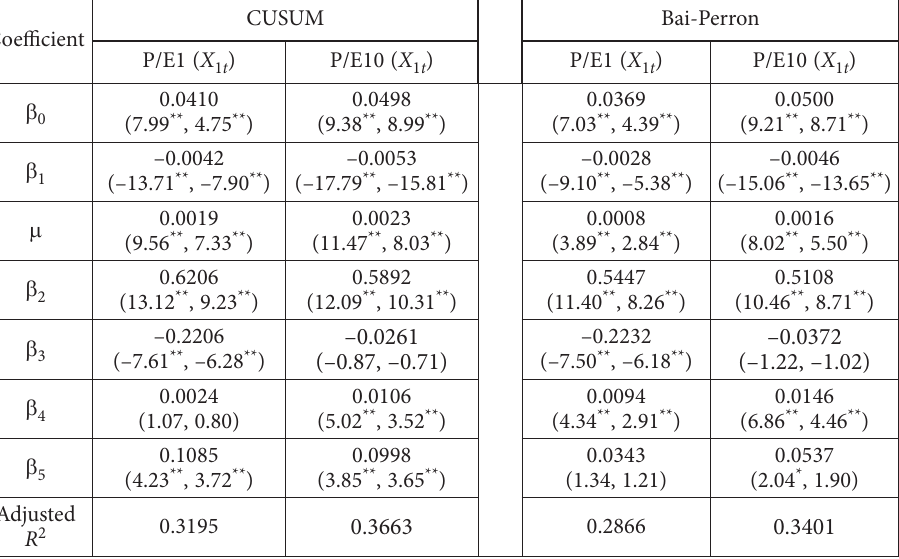
Table 4. Regression results